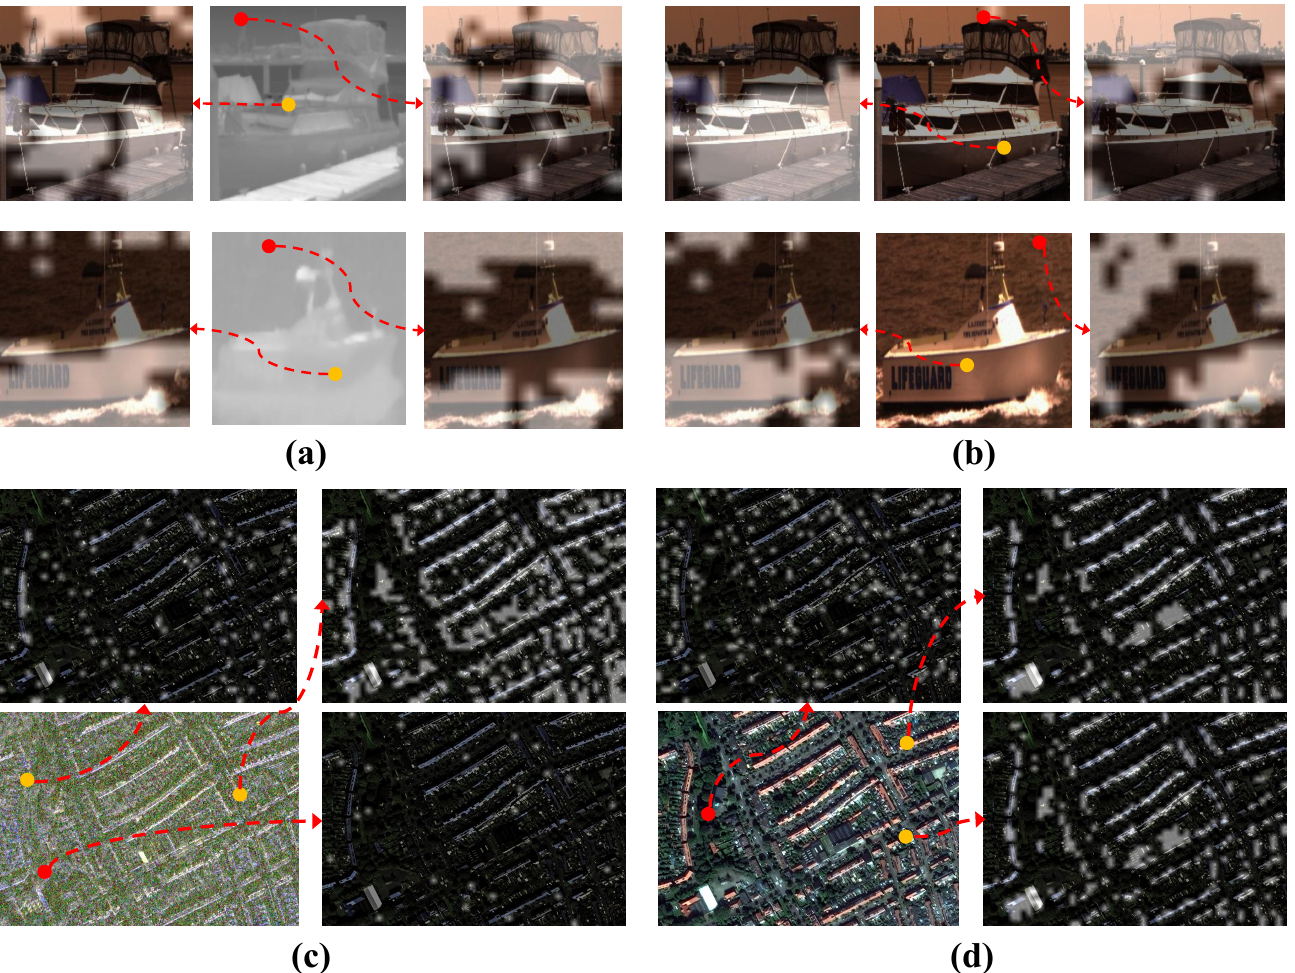
Figure 5. Attention maps of the picked points. ( a – d ) are the attention maps from classification and semantic segmentation, respectively. ( a , c ) are multi-source cross-attention maps. ( b , d ) are single- source self-attention maps. The figures indicated by the arrow show the global attention maps of the picked query point. The red points represent the background queries, and the yellow points are the foreground